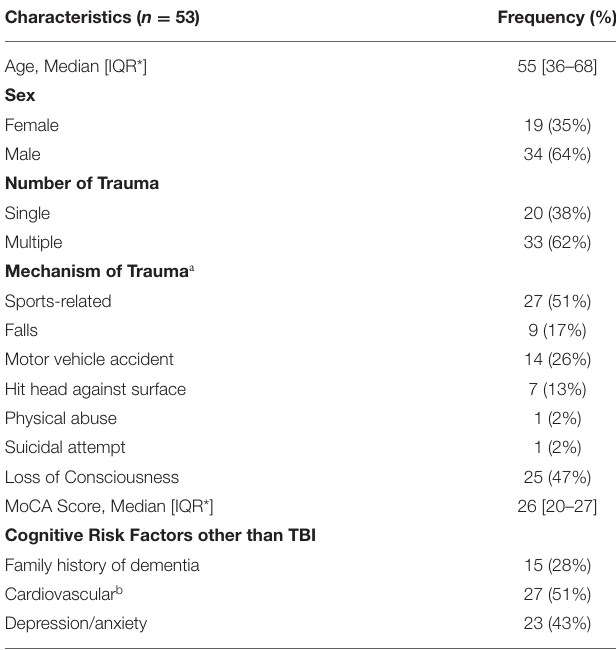
TABLE 1 | Demographic characteristics and description of subjects with post-concussive symptoms.